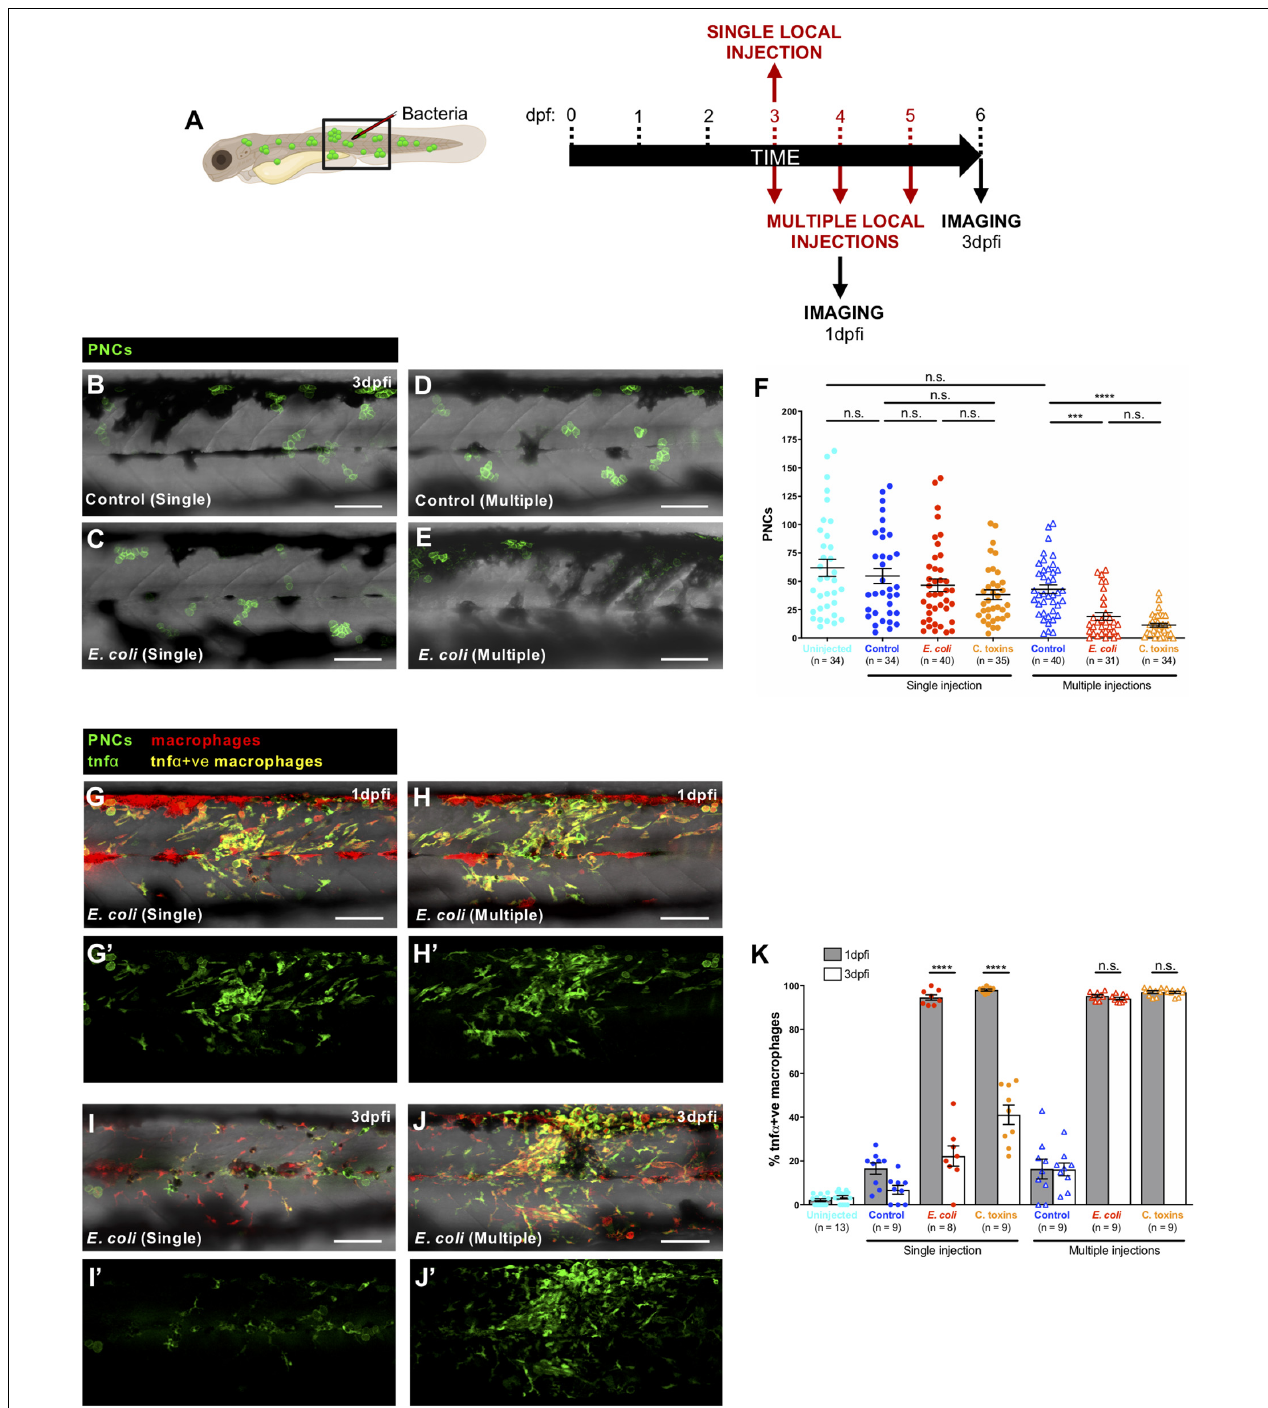
FIGURE 4 | Prolonged pro-inflammatory response and reduction in cancer cell numbers upon consecutive local injections of E. coli or Coley’s toxins. (A) Schematic of the experimental timeline for single/multiple locally infected cancer studies showing the region (black box) to be imaged in (B–E,G–J) . (B–E) Multi-channel confocal images of the flank of cancerous Tg( kita:HRASG12V-GFP ) larvae showing pre-neoplastic cells (green) at 3 dpfi after single vs. multiple local injections of control media (B,D) or E. coli (C,E) . (F) Graph showing number of pre-neoplastic cells following each treatment. (G–J) Multi-channel confocal images of the flank of cancerous Tg( kita:HRASG12V-GFP;mpeg1:mCherry;tnf α :GFP ) showing pre-neoplastic cells (green) and tnf α -positive macrophages (yellow) (tnf α -negative macrophages are red) at 1 dpfi (G,H) or 3 dpfi (I,J) after single vs. multiple local injections of E. coli . (G’–J’) Single-channel confocal images of the same larvae showing GFP-expressing cells (pre-neoplastic cells and tnf α -positive cells). (K) Graph showing the percentage of tnf α -positive macrophages at two timepoints for all of the injection regimes. Scale bars = 100 µ m.